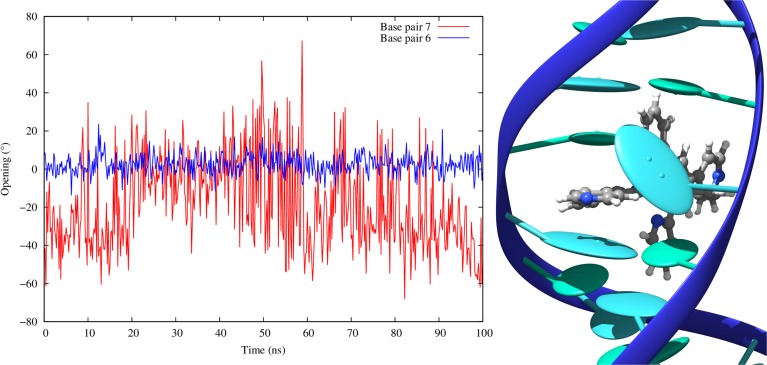
Time evolution of the opening parameter for base pair 6 and 7 in the case of intercalated FeC-3 in the poly(dG)-poly(dC) double strand. On the right we report the cartoon of a representative conformation obtained during the MD showing the partial insertion and the ejection of Guanine 7.